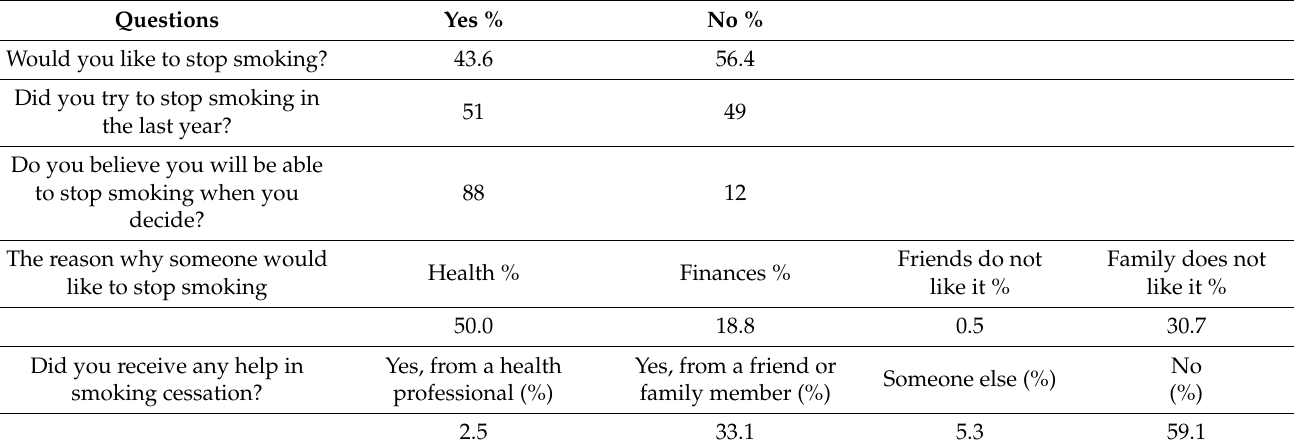
Table 5. Students’ attitudes related to smoking cessation ( n = 410).